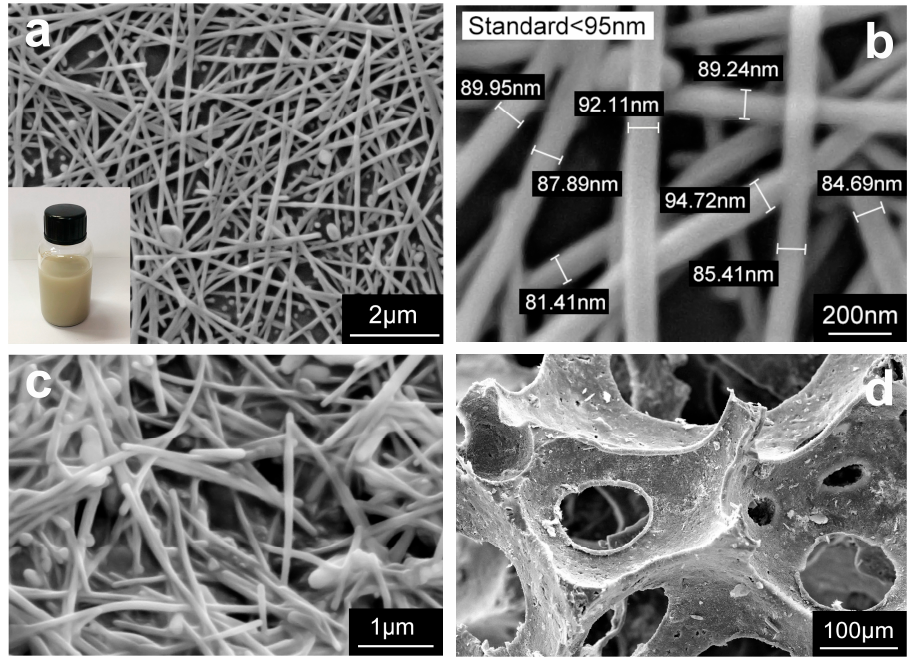
Figure 3. SEM micrographs of various parts of the samples: ( a ) SEM image for network structure of AgNWs at low stirring rate (inset: AgNWs suspensions in ethanol); ( b ) SEM confirms that the diameters of silver nanowires less than 100 nm; ( c , d ) SEM images of NRLF under different magnifications after AgNWs solution coating with one time.